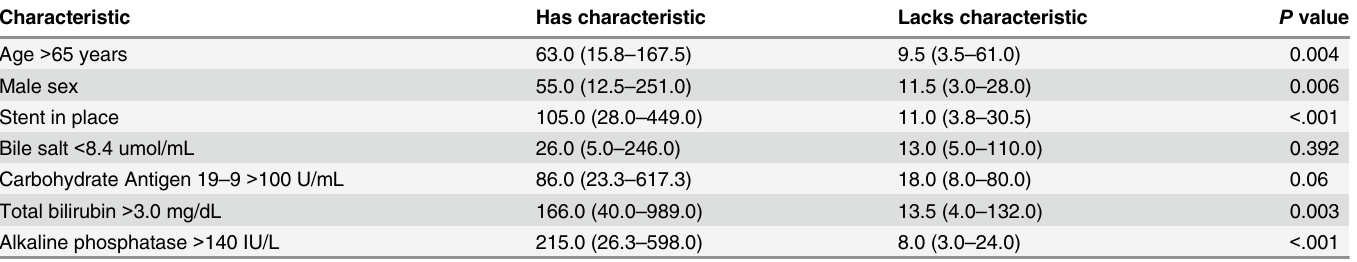
Alkaline phosphatase > 140